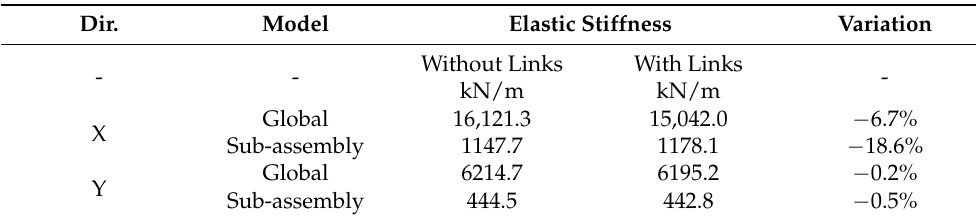
Table 2. Results for the existing structure in terms of elastic stiffness evaluated accounting for/disregarding the local connection performance.